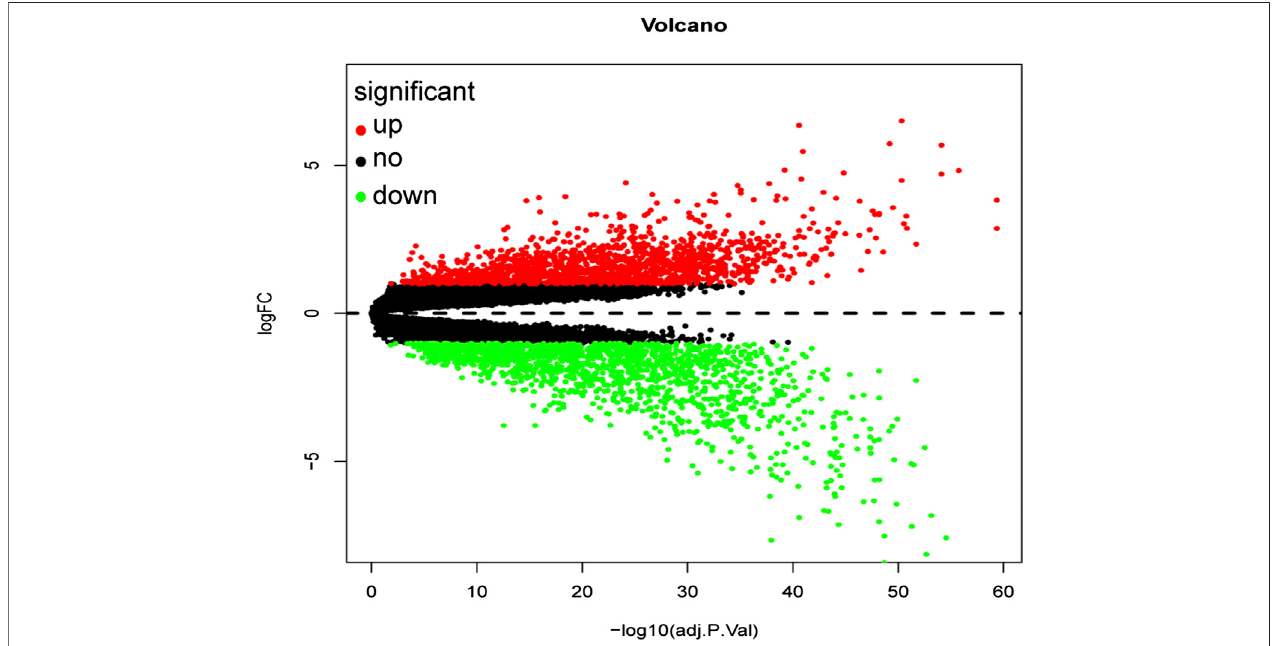
FIGURE 2 | Volcano plot of all differentially expressed genes in GSE53757. A total of 1,579 genes were up-regulated while 1,659 genes were down-regulated. Red: up-regulated DEGs; Black: unchanged DEGs; Green: down-regulated